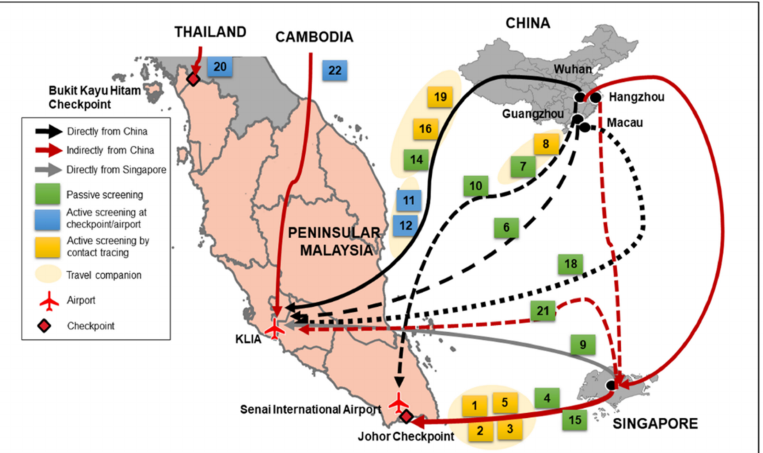
Figure 3. Spatial spread of COVID-19 into Malaysia during the first wave. (Numbers in boxes represent the case number).